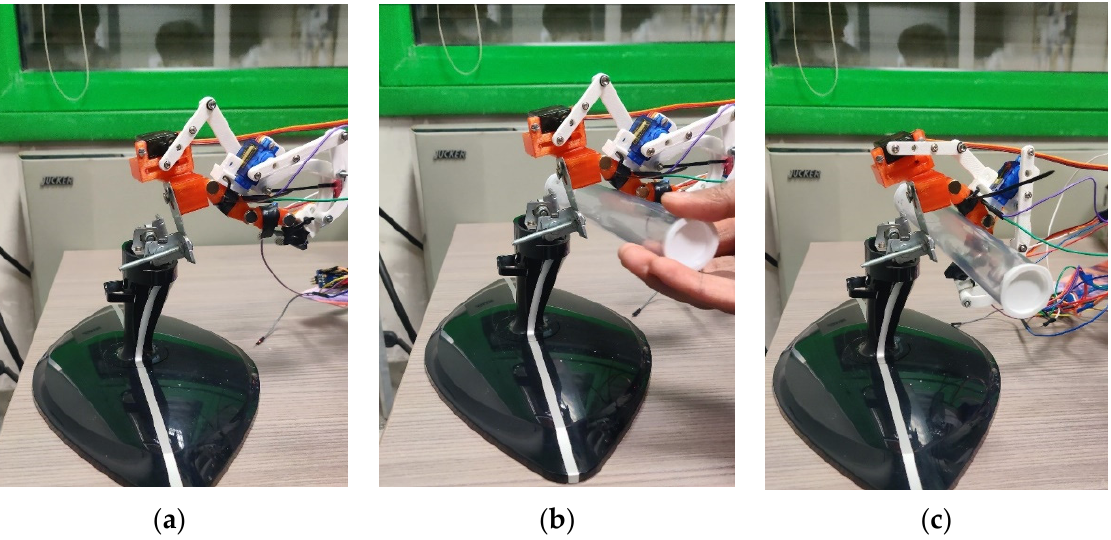
Figure 8. Grasping sequence of a rigid stick: ( a ). The initial position to grasp, ( b ). performing the grasp, ( c ). Successful grasp.